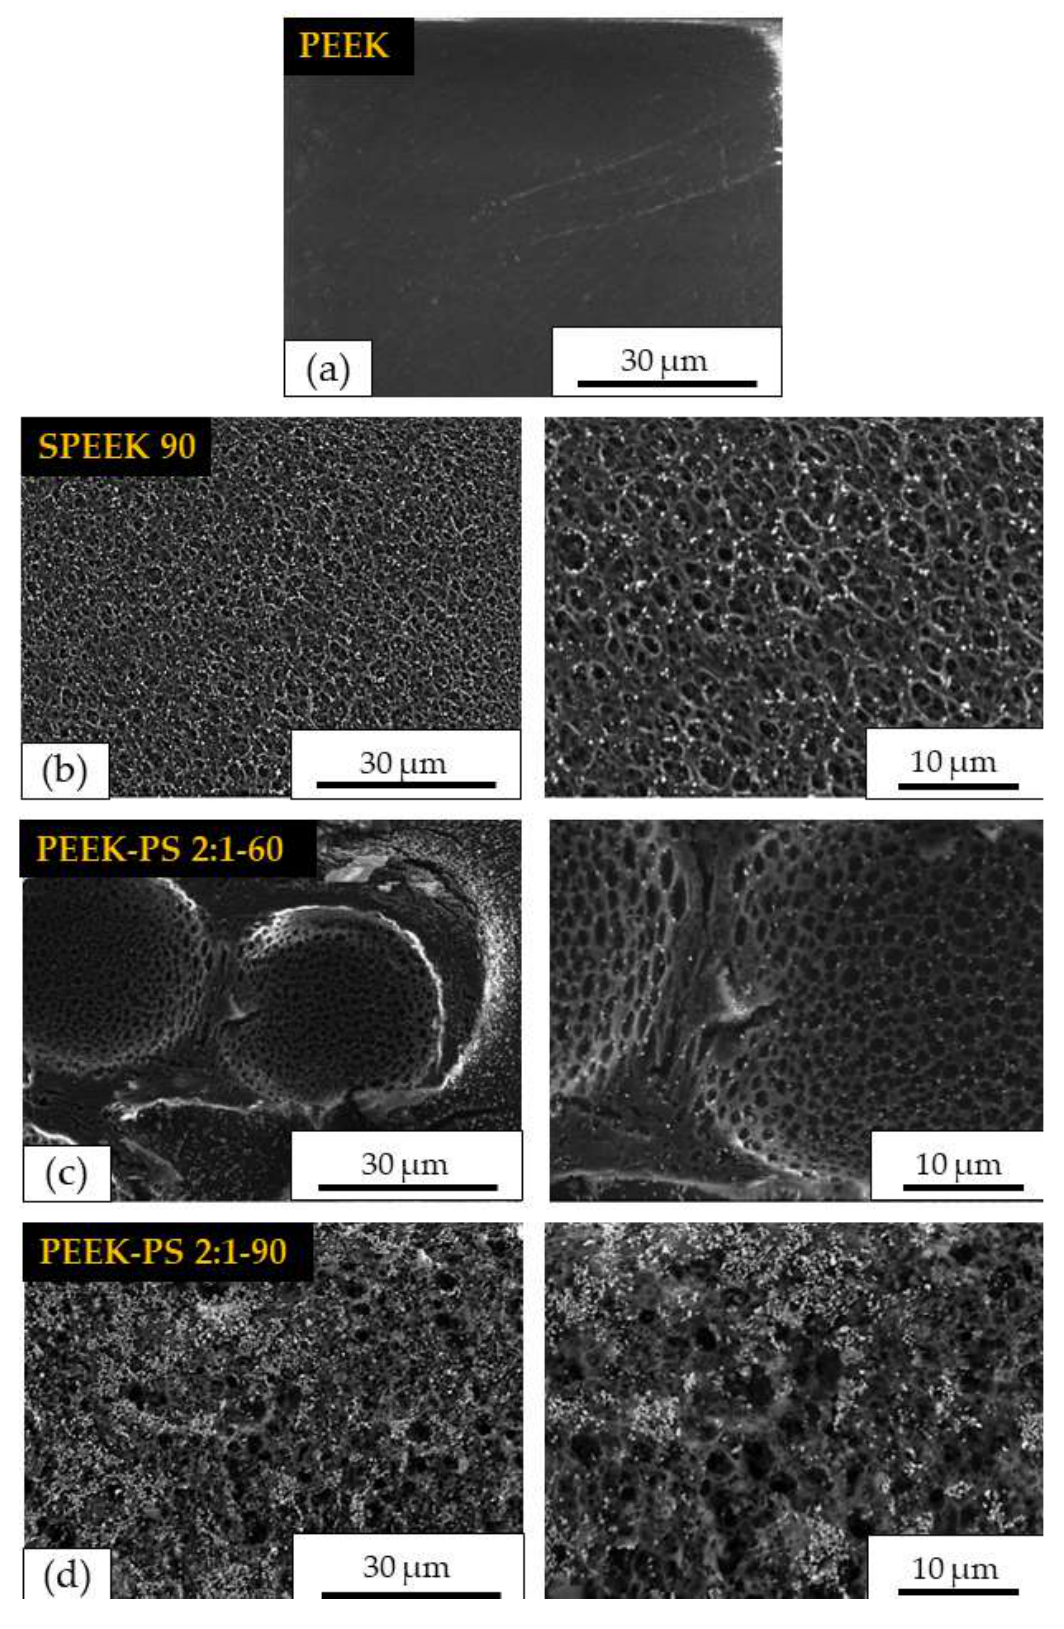
Figure 8. Comparison between surface micrographs of PEEK (a), SPEEK 90 (b), PEEK-PS 2:1-60 (c), and PEEK-PS 2:1-90 (d) with different magnifications.